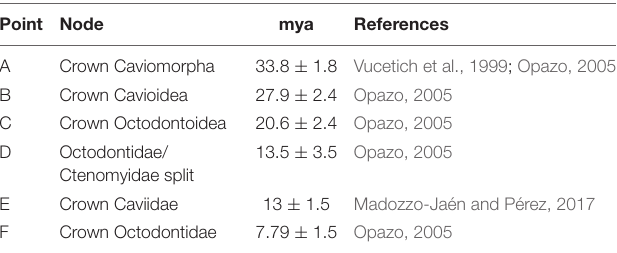
TABLE 2 | Calibration nodes used in this study (A–F), ages are expressed in million years ago (mya), normal distribution was used in every node and publication reference of each one is